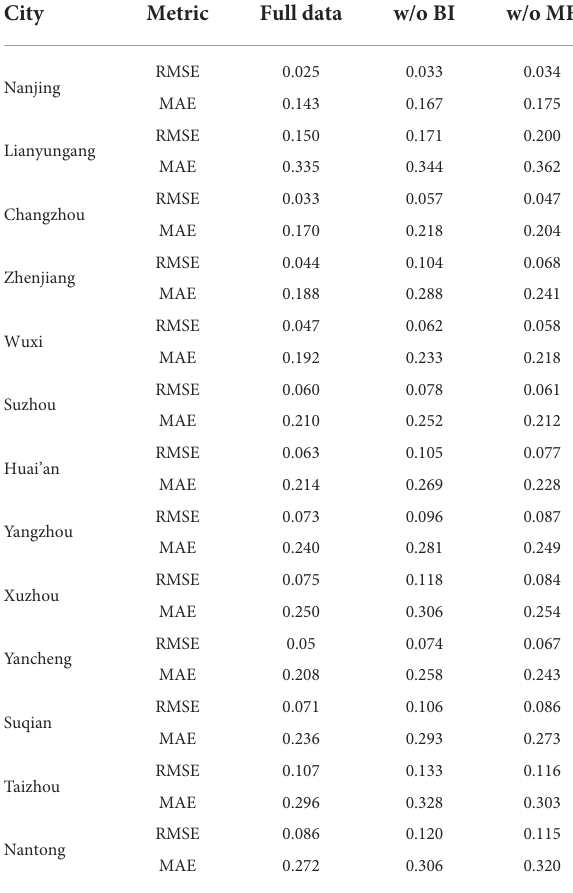
TABLE 4 The comparison results of our BiLSTM-Attention model with different training data on predicting monthly incidence rates of hepatitis E for the 13 cities in Jiangsu